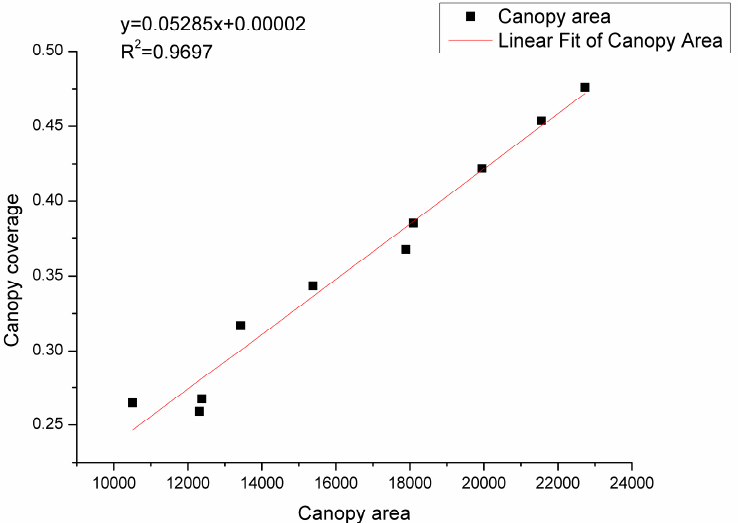
Table 7. Summary of the results including the area of the canopy, the area of coverage, and the canopy coverage.